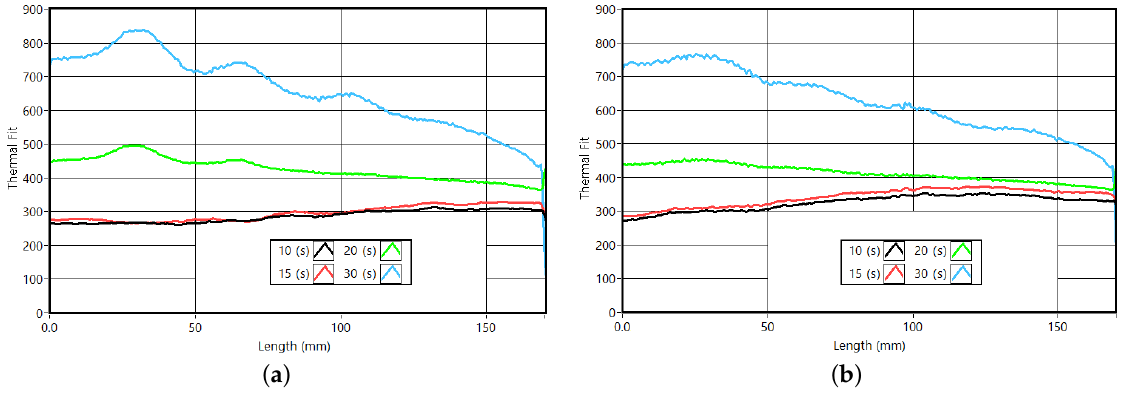
Figure 19. Vertical amplitude profiles for two slots. ( a ) Thermal profiles for the slot 2 mm thick. ( b ) Thermal profiles for the slots 4 mm